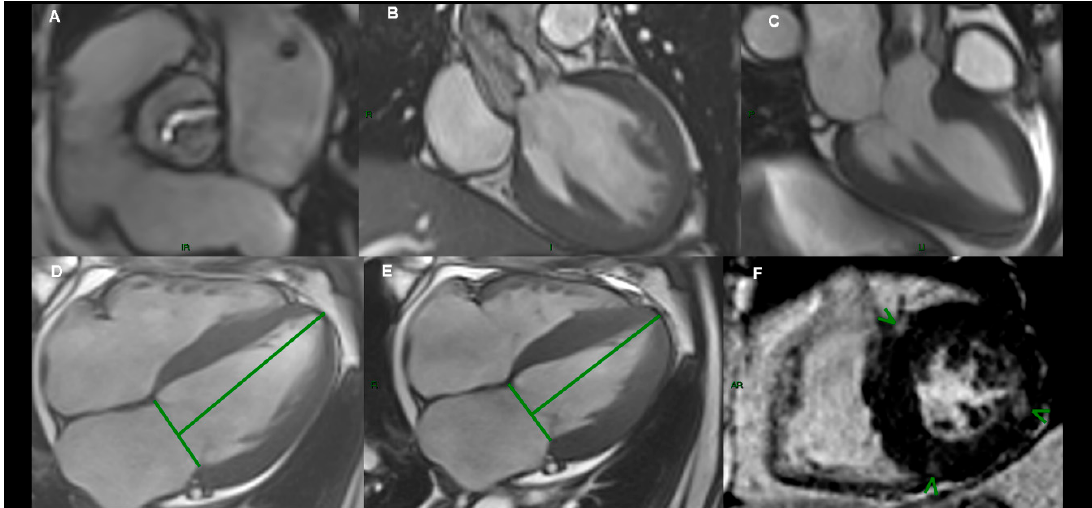
Figure 2. Cardiovascular magnetic resonance (CMR) imaging in aortic stenosis (AS) patients. ( A ) cine-SSFP (steady-state free precession) imaging of a stenotic bicuspid aortic valve; ( B ) coronal left ventricular outflow tract view acquired through-plane showing the aortic valve leaflet tips and restricted leaflet motility and resultant high velocity jet; ( C ) three-chamber view acquired through-plane showing the aortic valve leaflet tips, restricted leaflet mobility, and high velocity jet; ( D , E ) four-chamber view at end-diastole and end-systole acquired for longitudinal axis strain (LAS); ( F ) late gadolinium enhancement (LGE) in short-axis views of left ventricle showing focal hyper-enhancement (arrow).